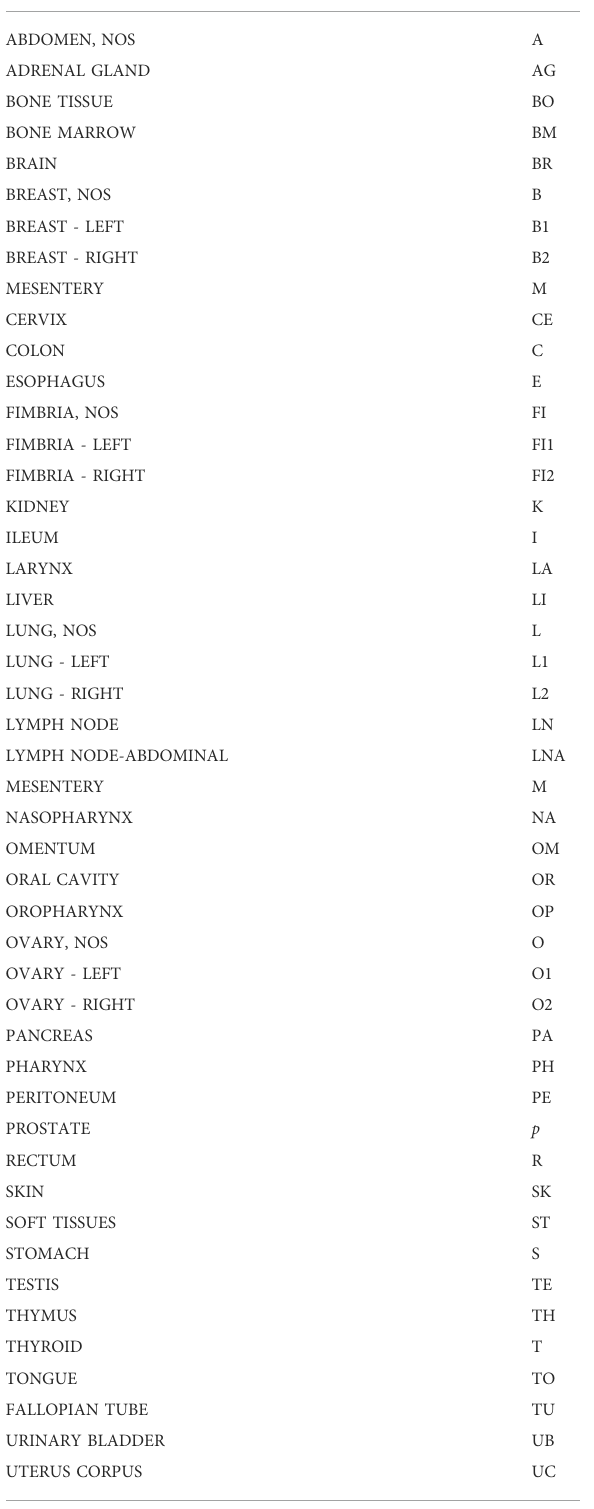
TABLE 2 Examples of tissue sample types and corresponding biobank codes.